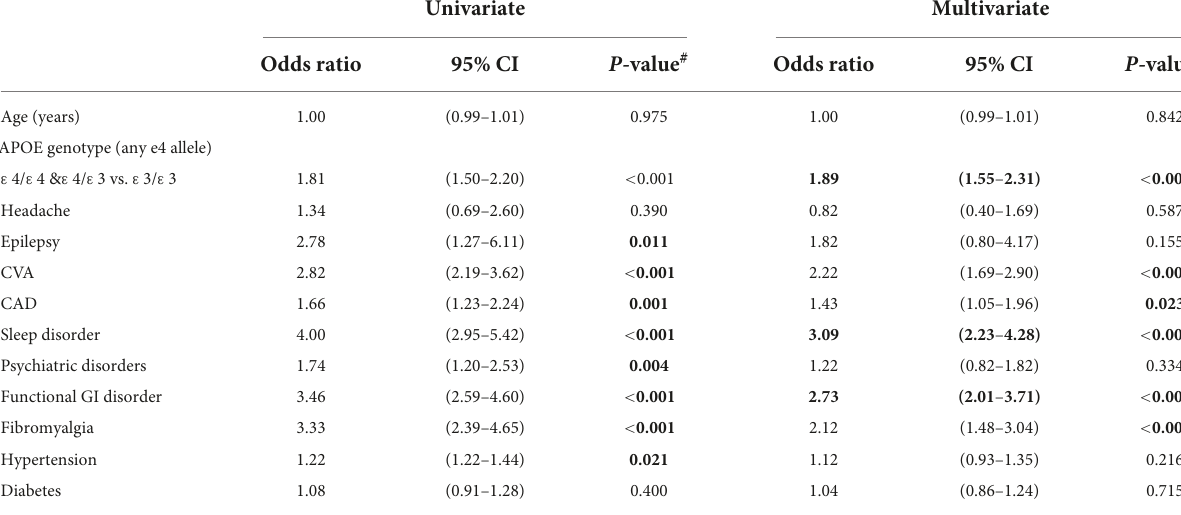
TABLE 2 Use of logistic regression to predict dementia development between 3 months and 3 years of presence of comorbidities.